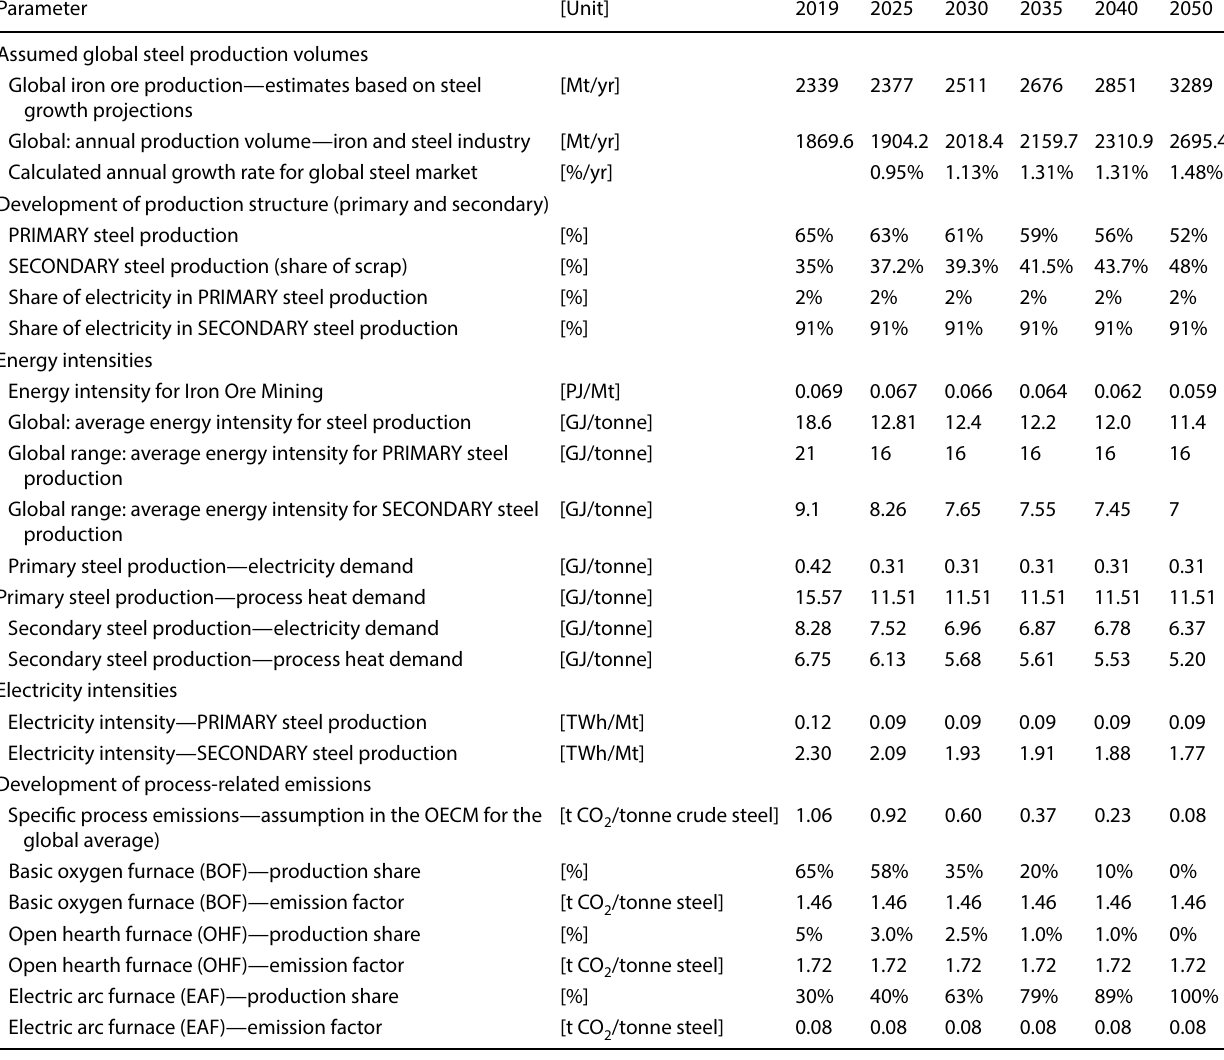
Table 13 Assumed market and energy intensity developments for the global steel industry according to the production process